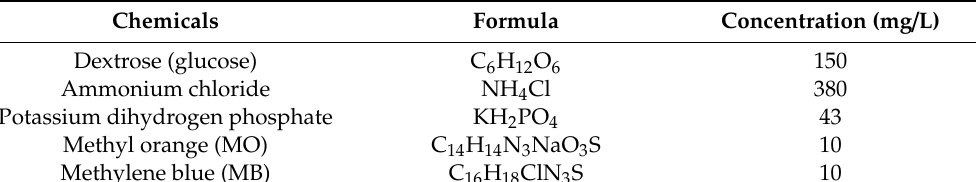
Table 2. Composition of pretreated simulated textile e ffl uent.